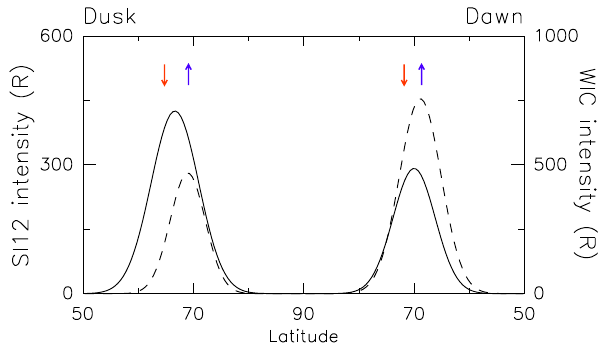
Fig. 8. The dawn-dusk meridian profiles of average auroral intensity (category IV, pre-onset) as observed by SI12 (solid curves) and WIC (dashed curves), as well as the average locations of the upward (blue arrows) and downward (red arrows) region 1 and 2 field-aligned currents identified by Iijima and Potemra